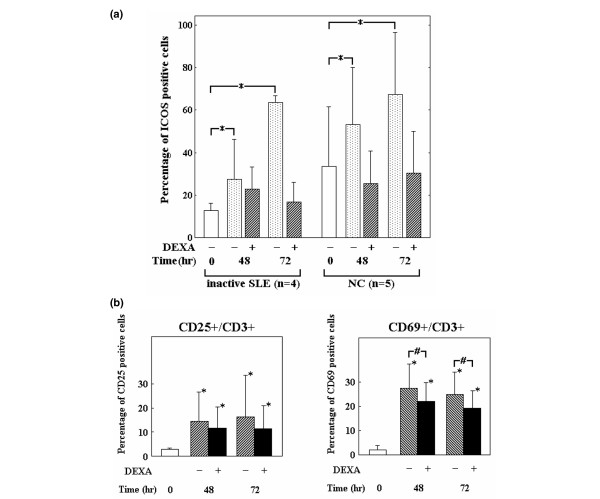
Effects of dexamethasone on ICOS expression after T cell activation. (a) Peripheral blood T cells from patients with inactive SLE (n = 4) and normal control individuals (n = 5) were cultured with ICOS co-stimulation for 48 or 72 hours in the presence or absence of 10-6 mol/l dexamethasone and were analyzed using three-colour staining (anti-CD3-PerCP, anti-CD45RO-PE, biotinylated JTA009 plus streptavidin-FITC) and flow cytometry for ICOS expression. ICOS co-stimulation significantly induced ICOS expression on CD3+CD45RO+ T cells in both patients with inactive SLE and normal control individuals (dotted columns). Dexamethasone at 10-6 mol/l almost completely abrogated the induction of ICOS after ICOS co-stimulation (hatched columns). The Y-axis showes percentages of ICOS+ cells among CD3+CD45RO+ cells. (b) Normal peripheral blood T cells (n = 4) were cultured with ICOS co-stimulation for 48 or 72 hours in the presence or absence of 10-6 mol/l dexamethasone and were analyzed using two-color staining (left panel, anti-CD3-FITC and anti-CD25-PE; right panel, anti-CD3-FITC and anti-CD69-PE) and flow cytometry. *P < 0.05 versus before stimulation, by Wilcoxon rank sum test. #P < 0.05 versus without dexamethasone, by Wilcoxon rank sum test. DEXA, dexamethasone; FITC, fluorescein isothiocyanate; ICOS, inducible co-stimulator; NC, normal control; PE, phycoerythrin; PerCP, peridinin chlorophyll protein; SLE, systemic lupus erythematosus.